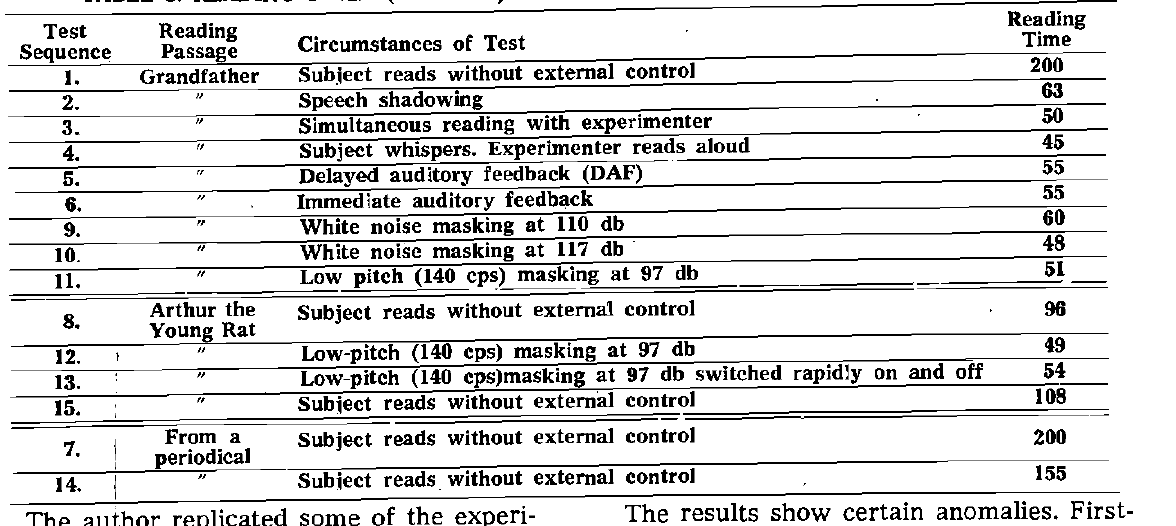
TABLE 3. READING TIMES (SECONDS) WITH AND WITHOUT EXTERNAL